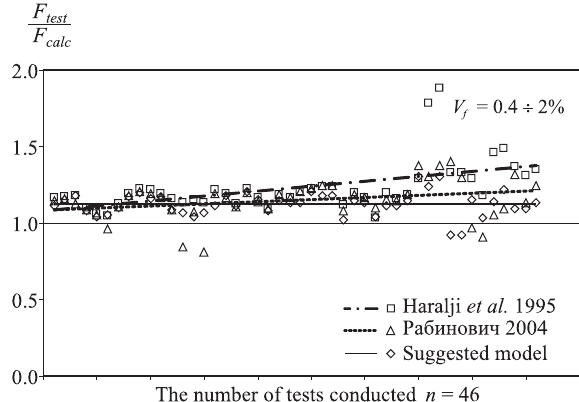
Fig. 11. Comparison of punching with steel fibres